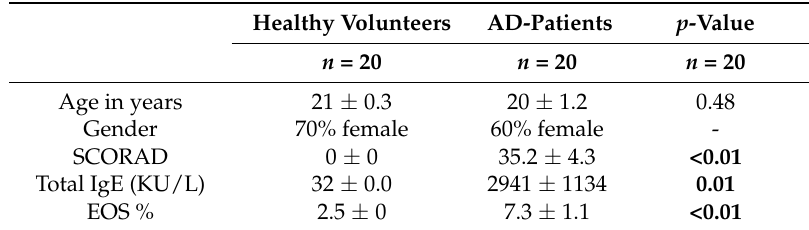
Table 1. Clinical and basic demographic data from healthy volunteers and atopic dermatitis (AD)-patients, mean ± SEM. Healthy Volunteers AD-Patients p -Value n = 20 n = 20 n = 20 Age in years 21 ± 0.3 20 ± 1.2 0.48 Gender 70% female - SCORAD 0 ± 0 35.2 ± 4.3 <0.01 Total IgE (KU/L) 32 ± 0.0 2941 ±